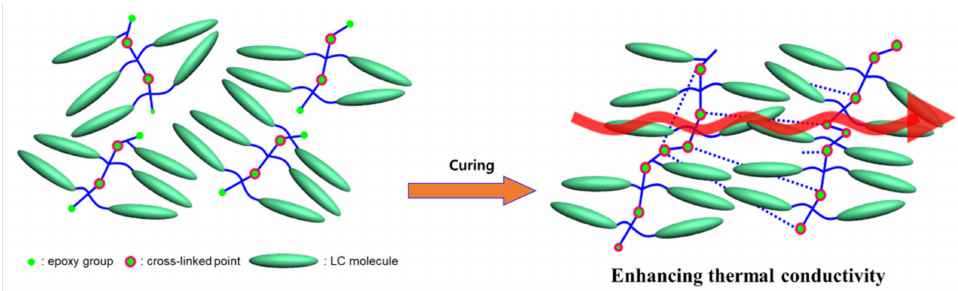
Figure 7. Schematic explanation of the correlation of liquid crystalline epoxy (LCE) bearing diglycidyl moieties at the side positions with thermal conductivity.